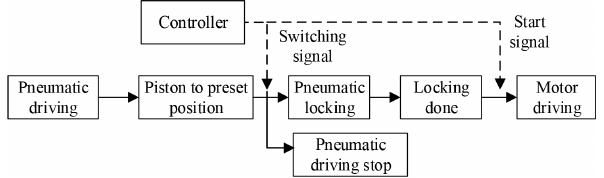
Figure 2. The stop then restart control